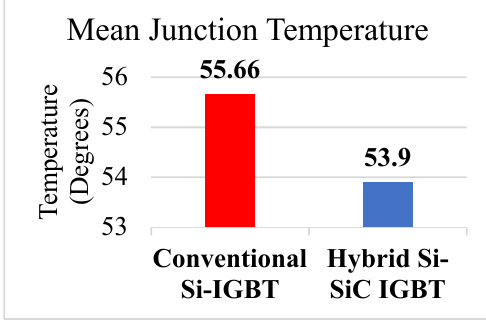
Figure 7. RF Matrix in India.